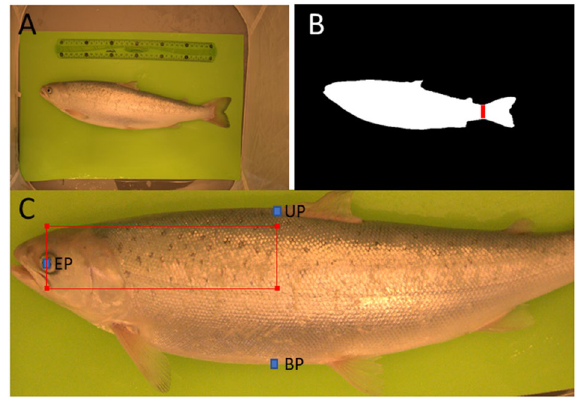
Figure 4. Process of ROI localization. A Original image of the fish in the tent. B Localized objective image of the fish with the narrowest area before the tail fin. C Fish with localized points EP (eye position), UP (upper fin beginning) and BP (belly point at the vertical position of UP); red rectangle represents the ROI.